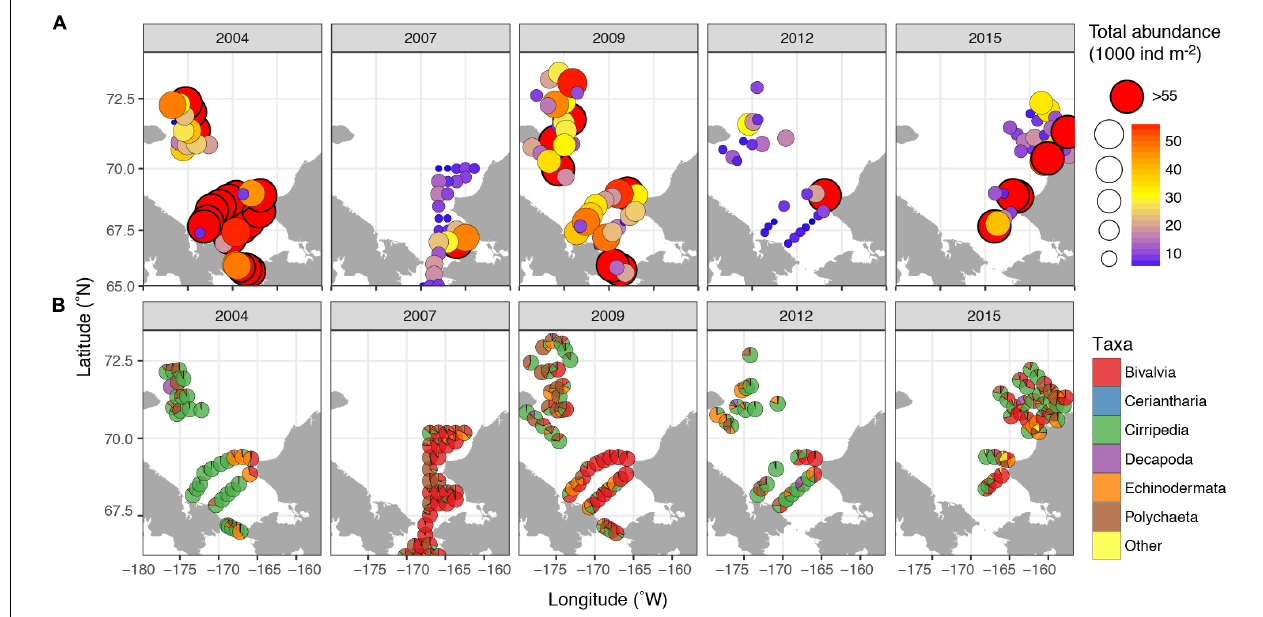
FIGURE 3 | Meroplankton abundance and composition in the Chukchi Sea during 2004, 2007, 2009, 2012, and 2015 (A) Total abundance of meroplankton; (B) relative contribution of different taxa of meroplankton. “Other” refers to Bryozoa and Gastropoda larvae.